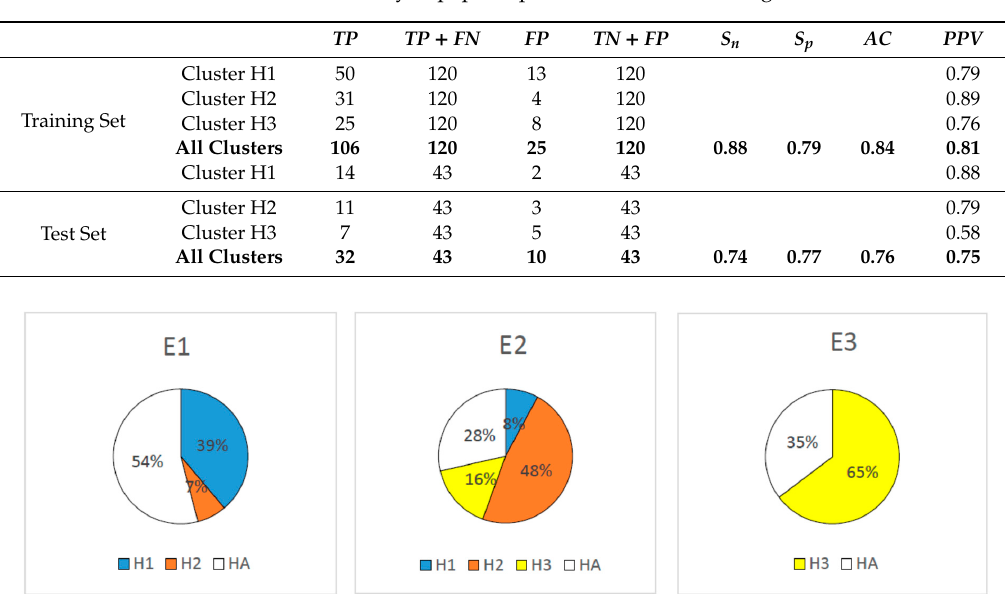
Table 2. Results of not hemolytic peptide prediction on the training and test sets.